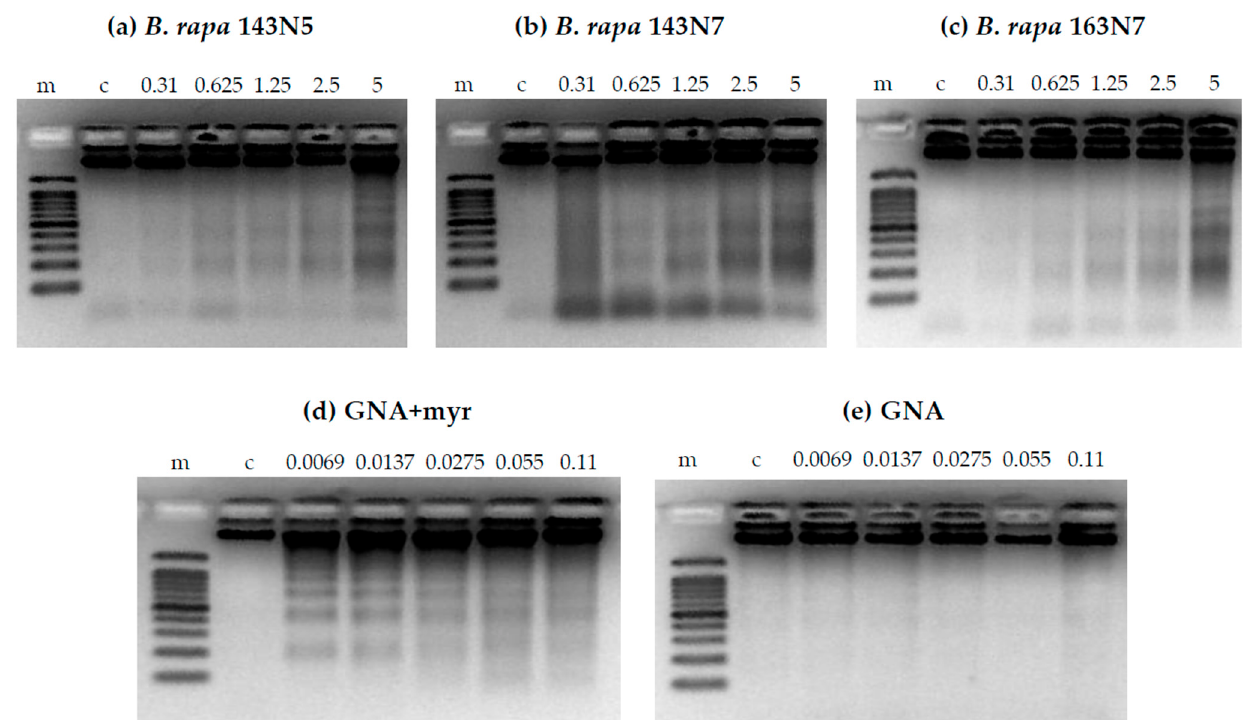
Figure 7. Genomic DNA degradation in HL-60 cells exposed to increasing concentrations of: ( a – c ) B. rapa (0.31, 0.625, 1.25, 2.5 and 5 mg/mL), ( d ) hydrolyzed and ( e ) non-hydrolyzed gluconapin (0.0069, 0.0137, 0.0275, 0.055 and 0.11 mg/mL) samples. 100 pb DNA ladder, PROMEGA (m) was electrophoresed as a base pair reference (Lane 1) and untreated cells (c) as control (Lane 2).